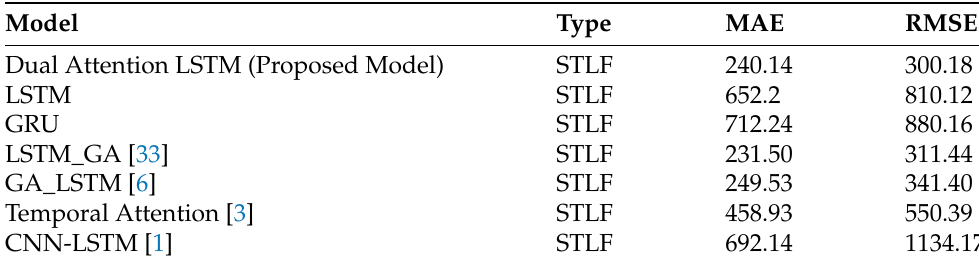
Table 5. Performance comparison with previous studies.